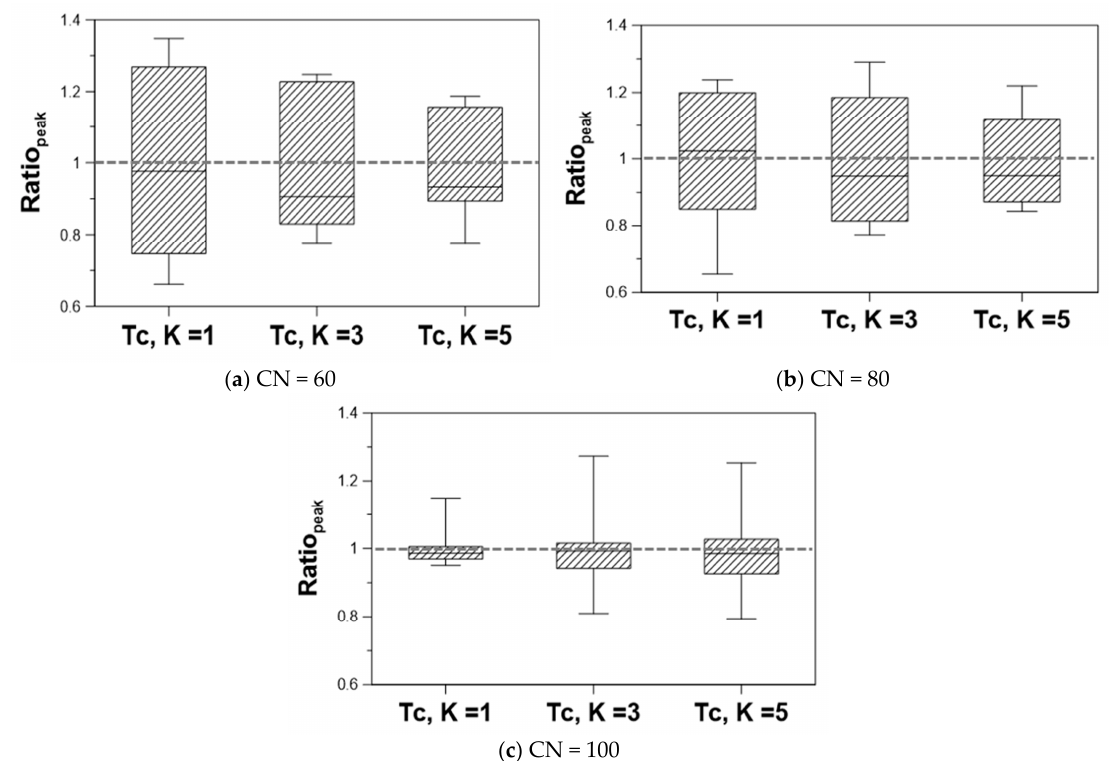
Figure 11. As for Figure 8, but with the randomly distributed rainfall histograms in Figure 9.